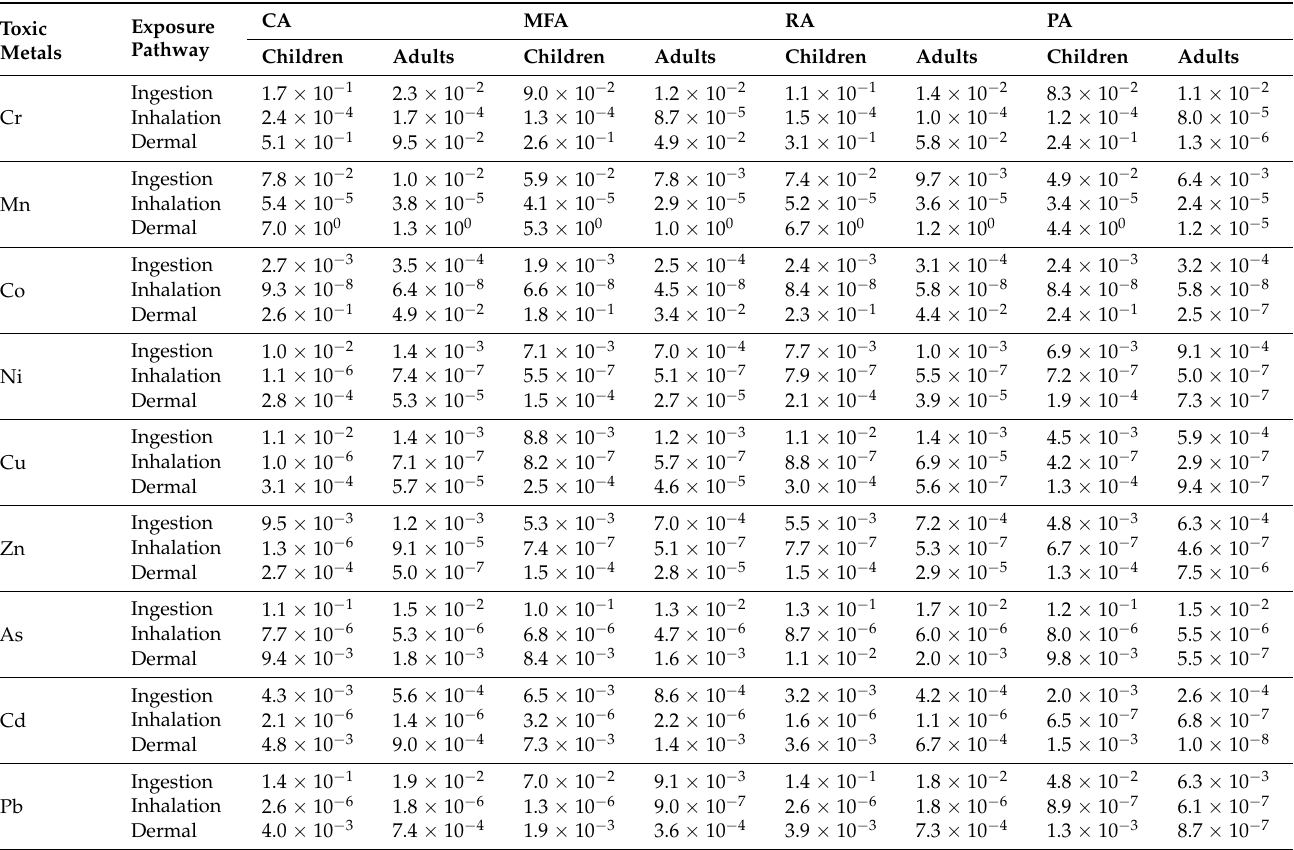
Table 3. Hazard quotient ( HQ ) of toxic metals through all exposure pathways in different land use areas of Mymensingh